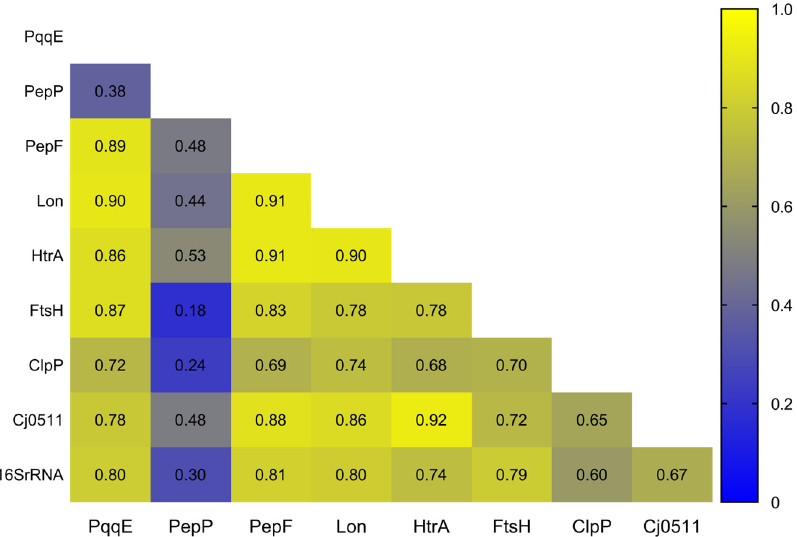
Figure 2. Pairwise Pearson correlation coefficients r of similarity matrices from seven proteases/peptidases and the 16S rRNA gene from 34 Campylobacter species . High pairwise r values (yellow boxes) indicate congruent evolutionary history, low r values (blue boxes) indicate independent and distinct evolutionary trajectories. For each protease/peptidase and the 16S rRNA gene, pairwise similarity matrices were calculated for all 34 Campylobacter species in MEGA X [112]. Protein analyses were conducted using the Poisson correction model, with ambiguous pairwise positions removed (pairwise deletion option). The 16S rRNA gene matrix was calculated using the Maximum Composite Likelihood model with the pairwise deletion option to remove ambiguous positions. The pairwise Pearson correlation coefficients r of the eight resulting similarity matrices were calculated using the PEARSON function implemented in Microsoft Excel. The heatmap was generated in GraphPad Prism 9.